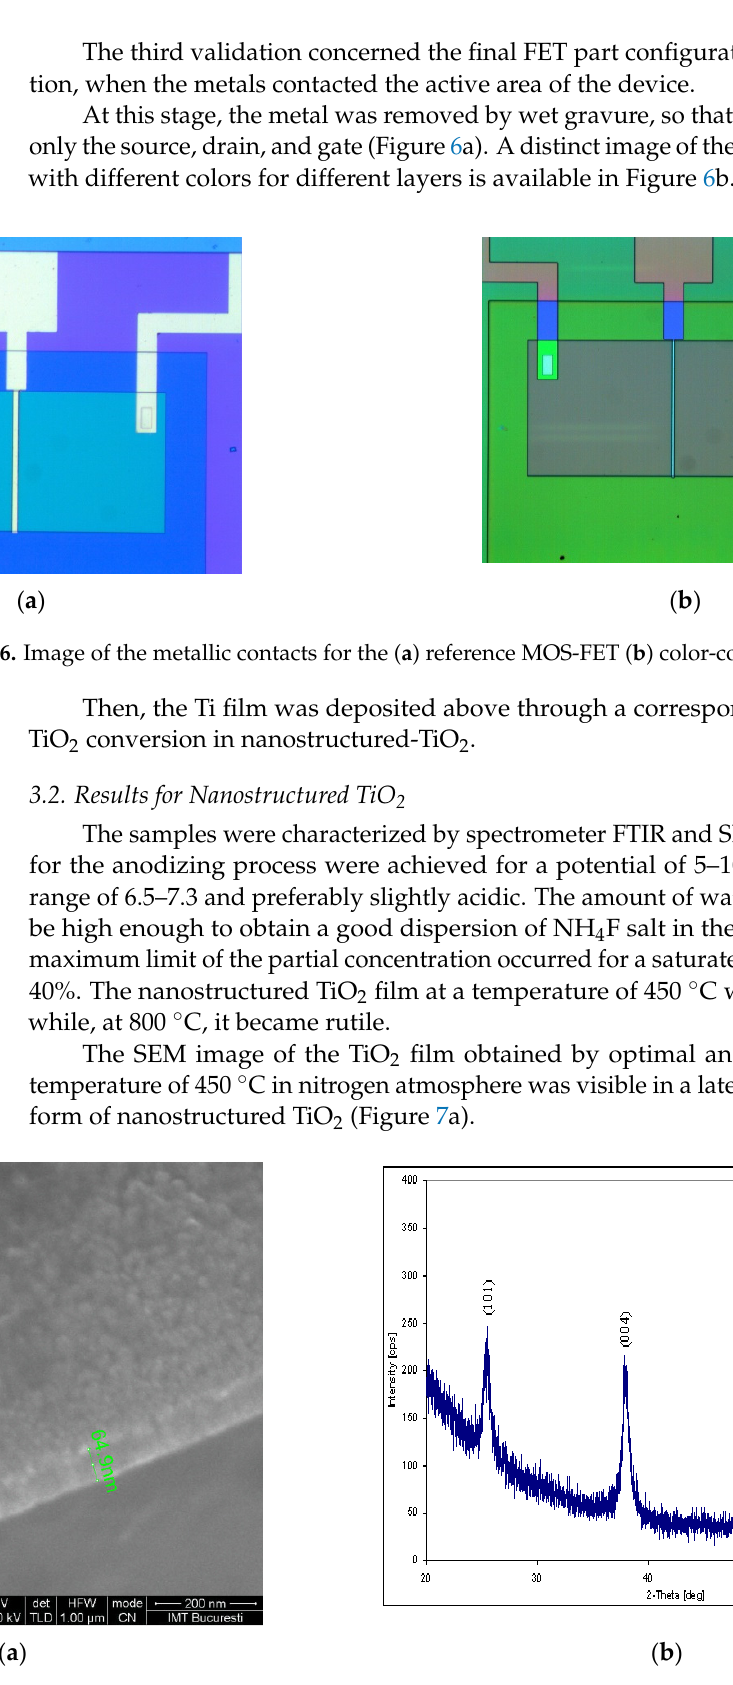
Figure 5. ( a ) Optical view of one external pad plus metallic trace to the source contact plus alignment sign and ( b ) details of the gold pad and gold trace to the source.